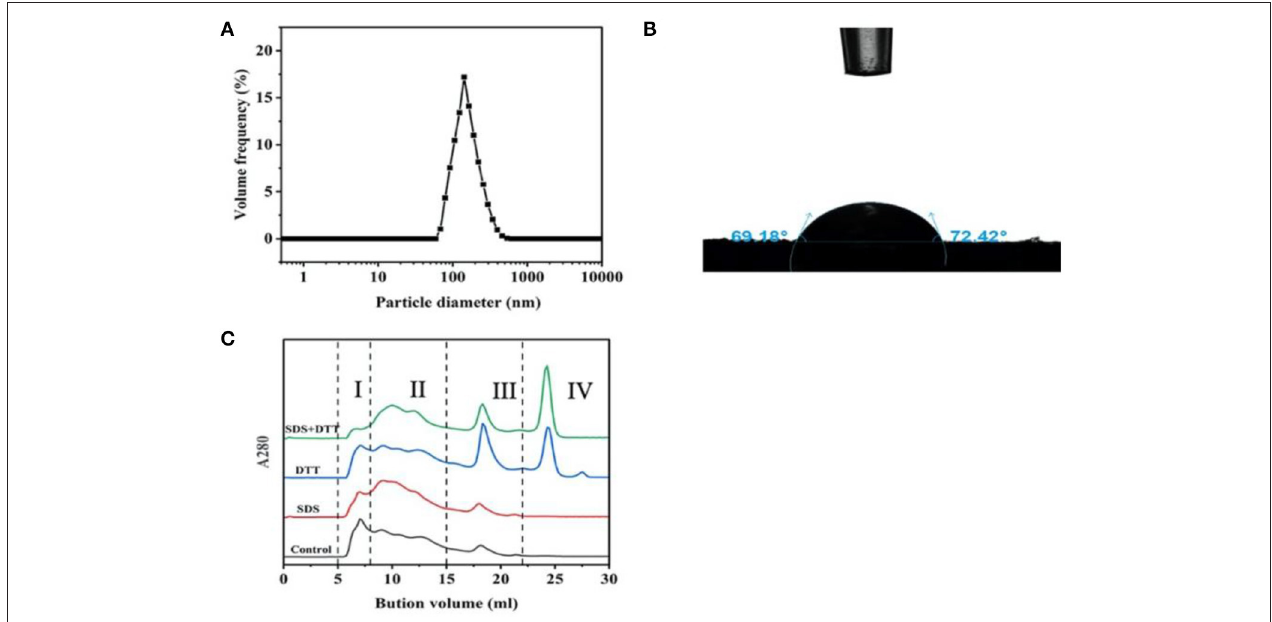
FIGURE 1 | Particle size distribution (A) , contact angle (B) , and aggregation behavior (C) of the proteins in the head of giant freshwater prawn.